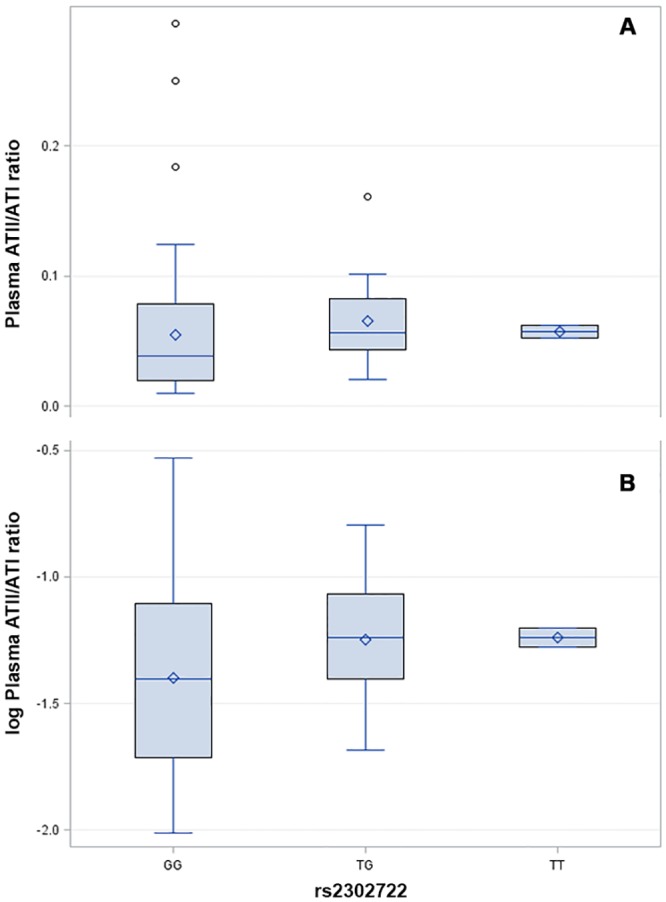
Distribution of the plasma angiotensin II (ATII)/ATI ratios (A) and logarithmic-transformed ATII/ATI ratios (B) according to CES1A1 rs2302722 genotypes.